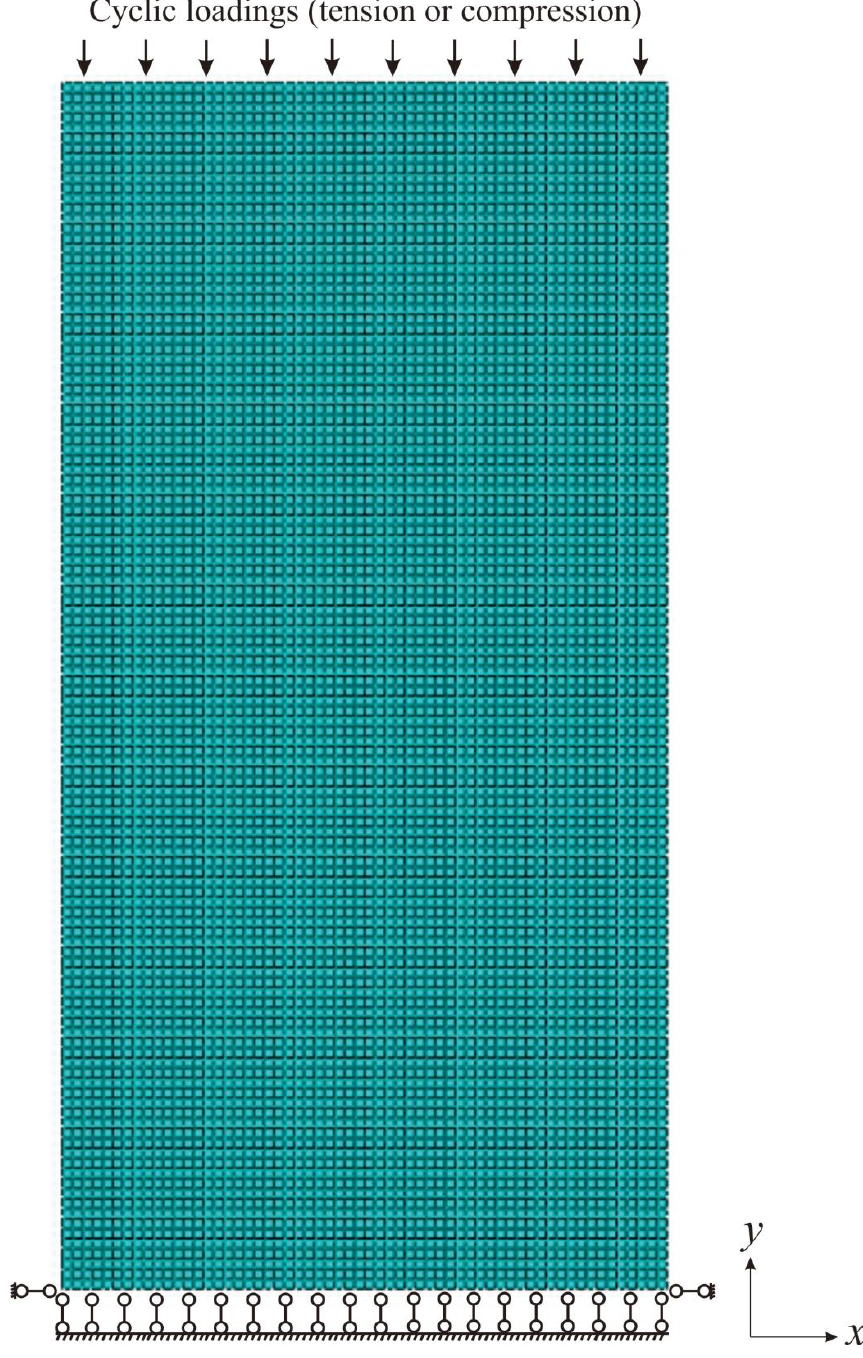
Figure 1. Illustration of the boundary conditions for sample used for fatigue simulations.